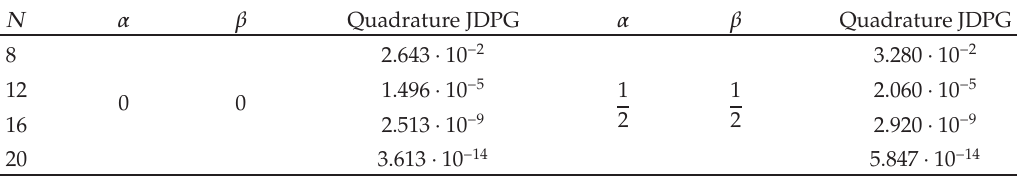
Table 4: Maximum pointwise error using quadrature JDPG method for N (cid:6) 12 , 16 , 20 , 24, for Example 5.4. N α